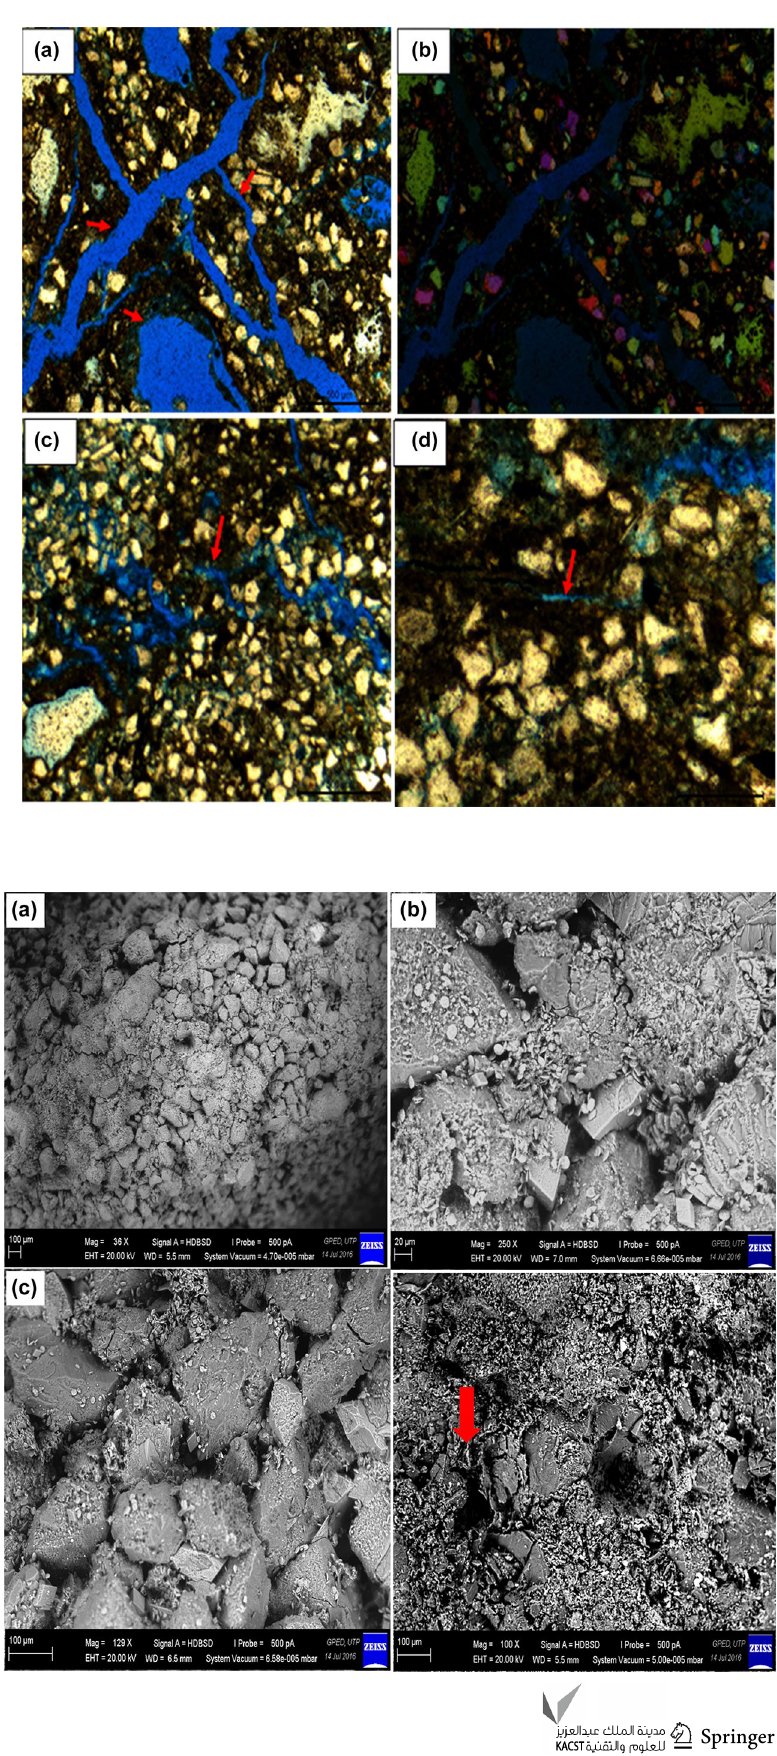
Fig. 12 Petrography of rock fabric variations. ( a ) Radial matrix-fracture pore system, ( b ) a crossed polar of opaque dark siderite, iron oxide of pore-filling matrix, ( c ) a granule size quartz grain with matrix-fracture pore, ( d ) a low- magnification matrix-fracture pore in MVFGS (WL4C13T7) lithofacies sandstone at depth at 1466.2 m